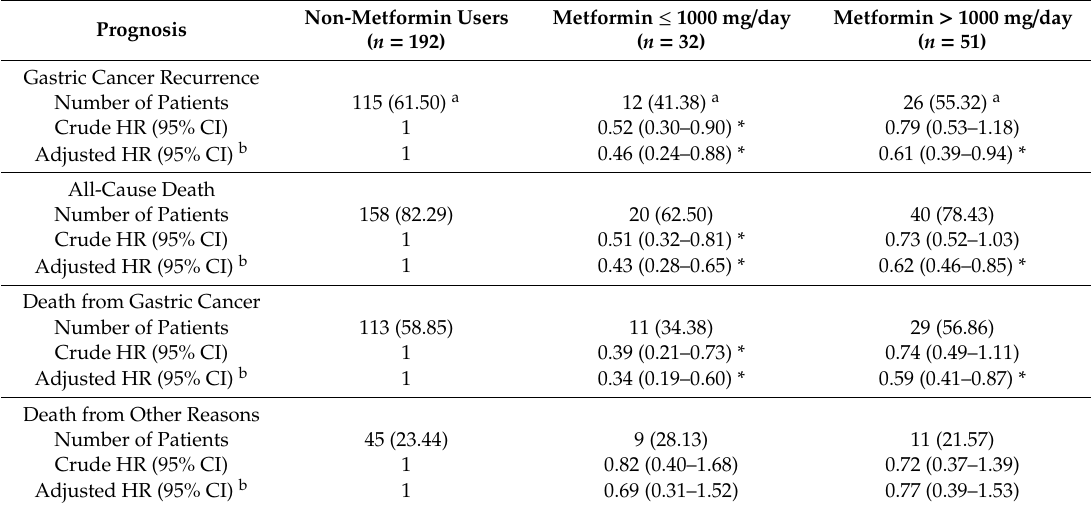
Table 4. Impact of metformin dosage on recurrence and death in patients with stage III GC and DM.